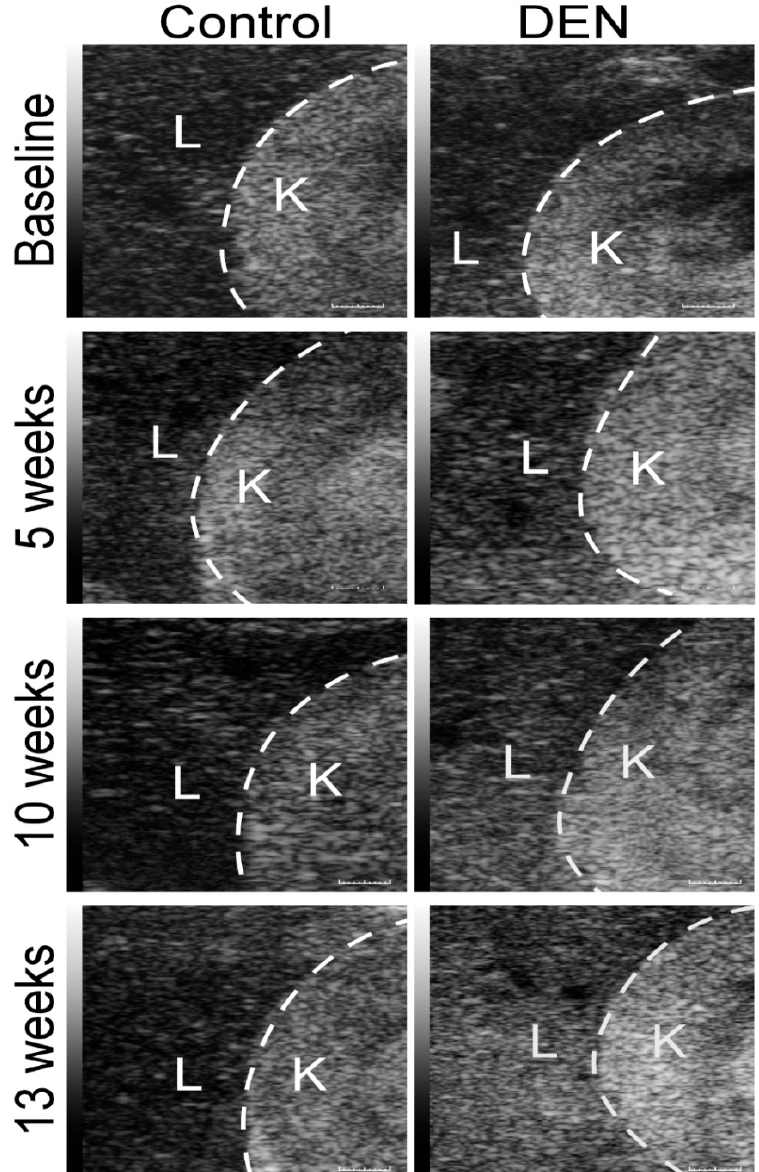
Figure 5. Sagittal B-mode ultrasound images of the right liver lobes of the control versus DEN-ingested rats. The images were made prior to the ingestion of DEN (baseline) and 5, 10, and 13 weeks after its administration. Note the progressive, qualitative increase in the echogenicity of the liver (L) with the development of hepatic fibrosis, so that by 13 weeks it is approaching that of the contiguous right kidney (K). Control rats showed no increase in liver echogenicity, which remained much less than that of the kidney over time. Scale bar = 1